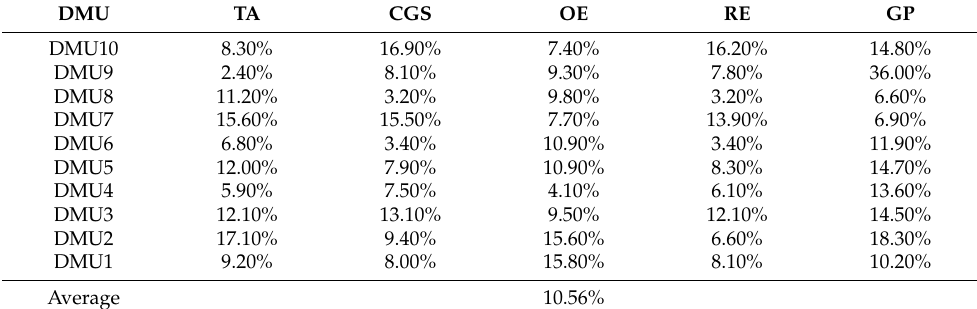
Table 4. The average MAPEs of the